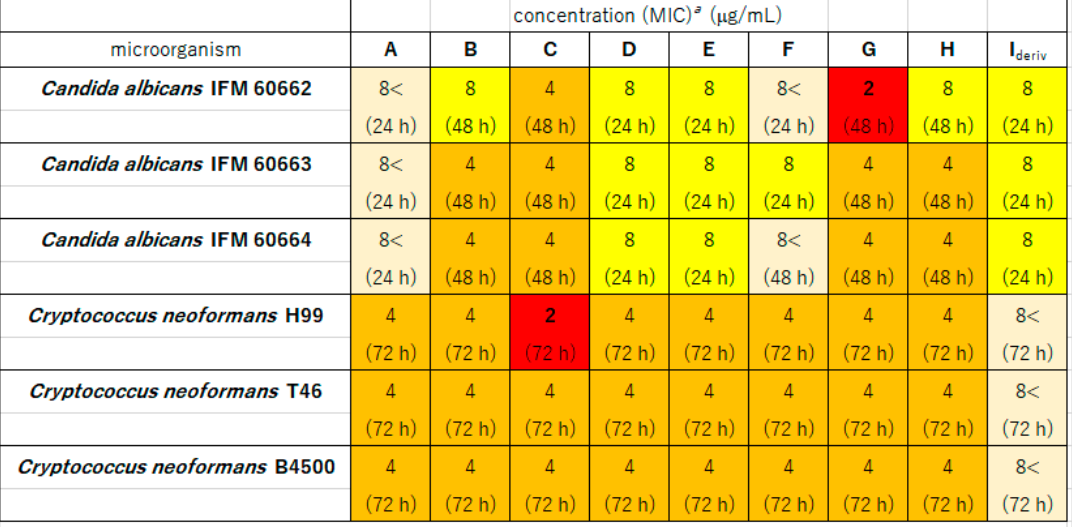
Figure 4. Antibacterial activity of eushearilide congeners A – H , I deriv , and related compounds. 3. Materials and Methods 3.1. Chemistry 3.1.1. General Information Optical rotations were determined using a Jasco P-1020 polarimeter. Infrared (IR) spectra were obtained using a Jasco FT/IR-4600 Fourier-transform infrared spectrometer. Proton and carbon